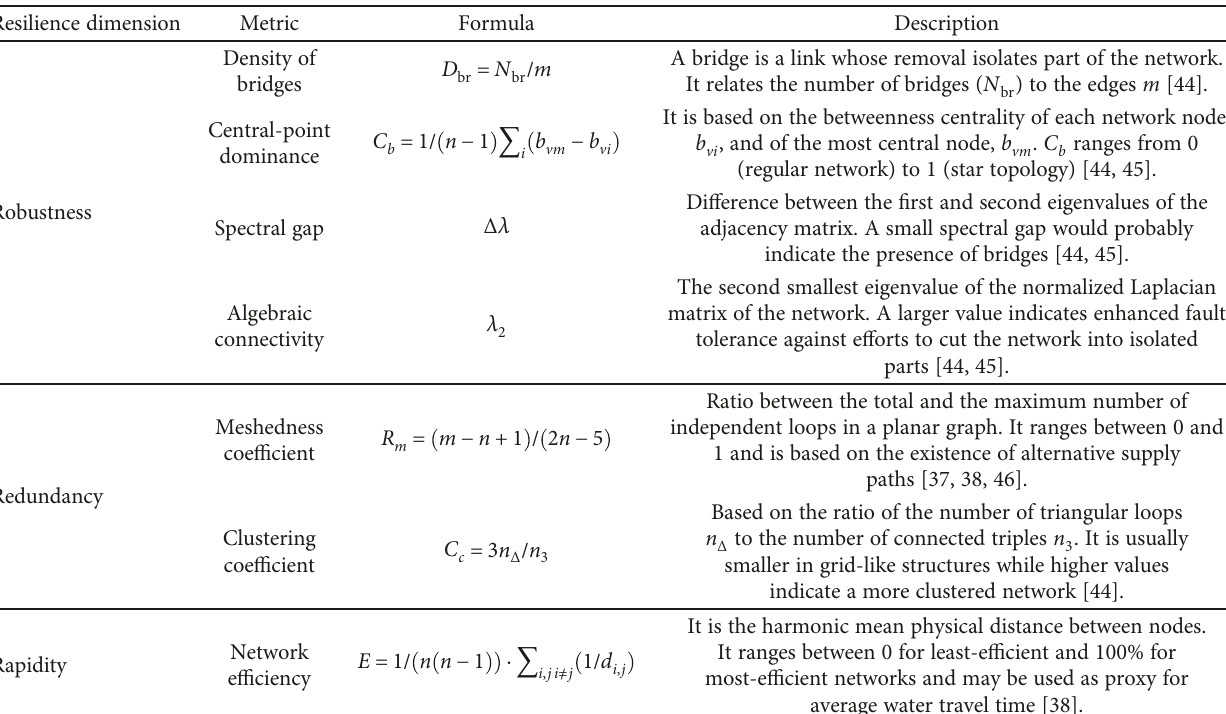
Table 2: GT metrics used for the analysis of the technical dimension of resilience. The number of WDS nodes and links is denoted by n and m ,